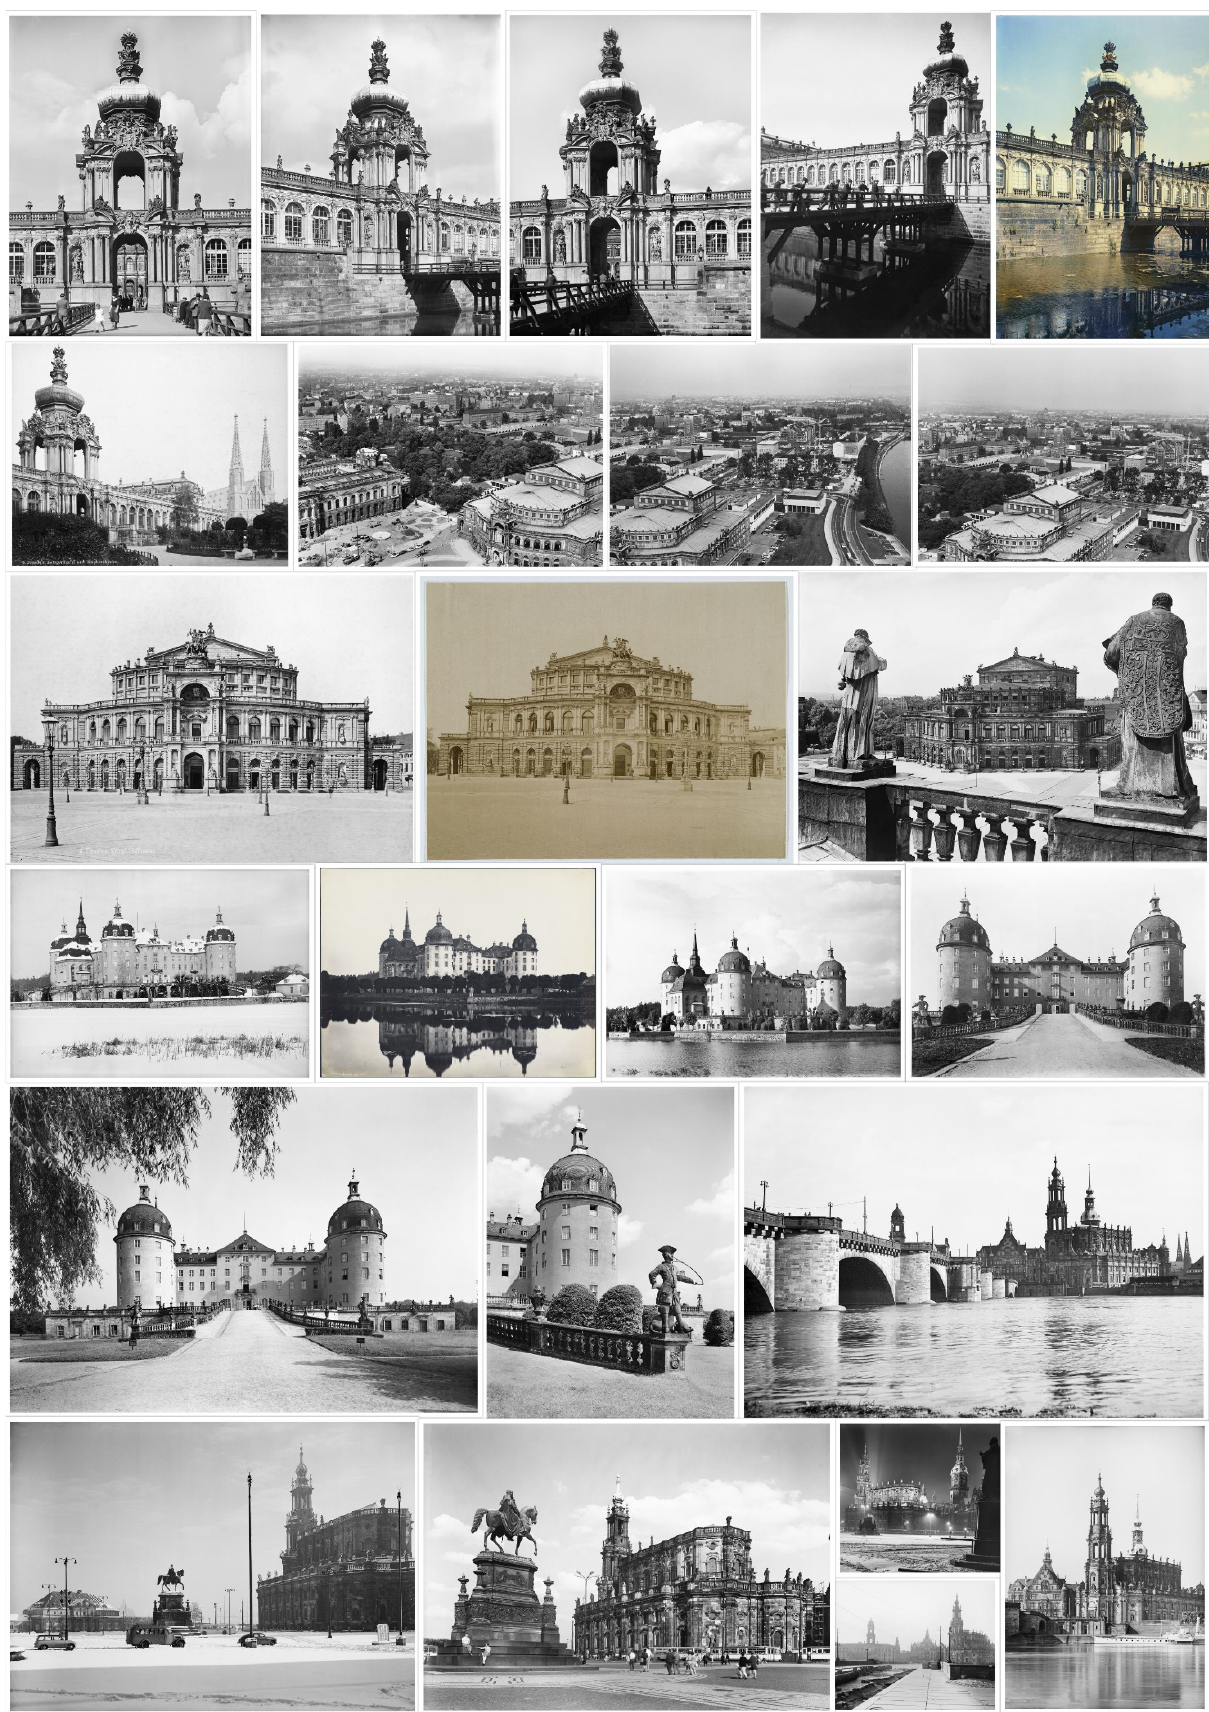
Figure 1. All current images of the benchmark dataset showing the variety of historical